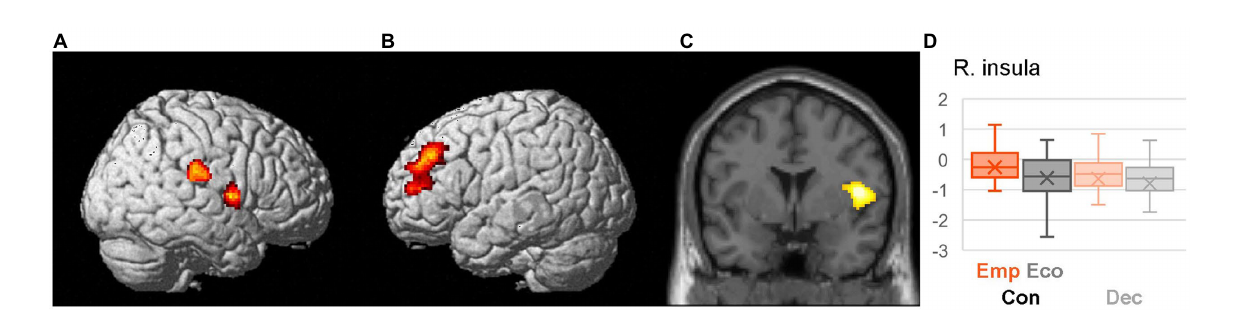
FIGURE 2 Differential activation during context presentation (EmpCon > EcoCon). Significantly higher activation during the thinking period of the context presentation for Emp than for Eco scenario (EmpCon_think > EcoCon_think) is presented in red-yellow color on the lateral surface of the right (A) and left (B) cerebral hemispheres as well as the coronal section ( y = 2) (C) of the standard anatomical image of SPM12. Boxplot (D) shows the activation profile of the right insula; each box extends from the 25th to the 75th percentile and the middle line denotes median value of estimated activation (against baseline) during Con_think period (i.e., vs. baseline) for Emp (orange) or Eco (gray) scenarios; vertical extending line denotes adjacent values (i.e., the most extreme values within 1.5 interquartile range of the 25th and 75th percentile), and the cross mark denotes the mean.